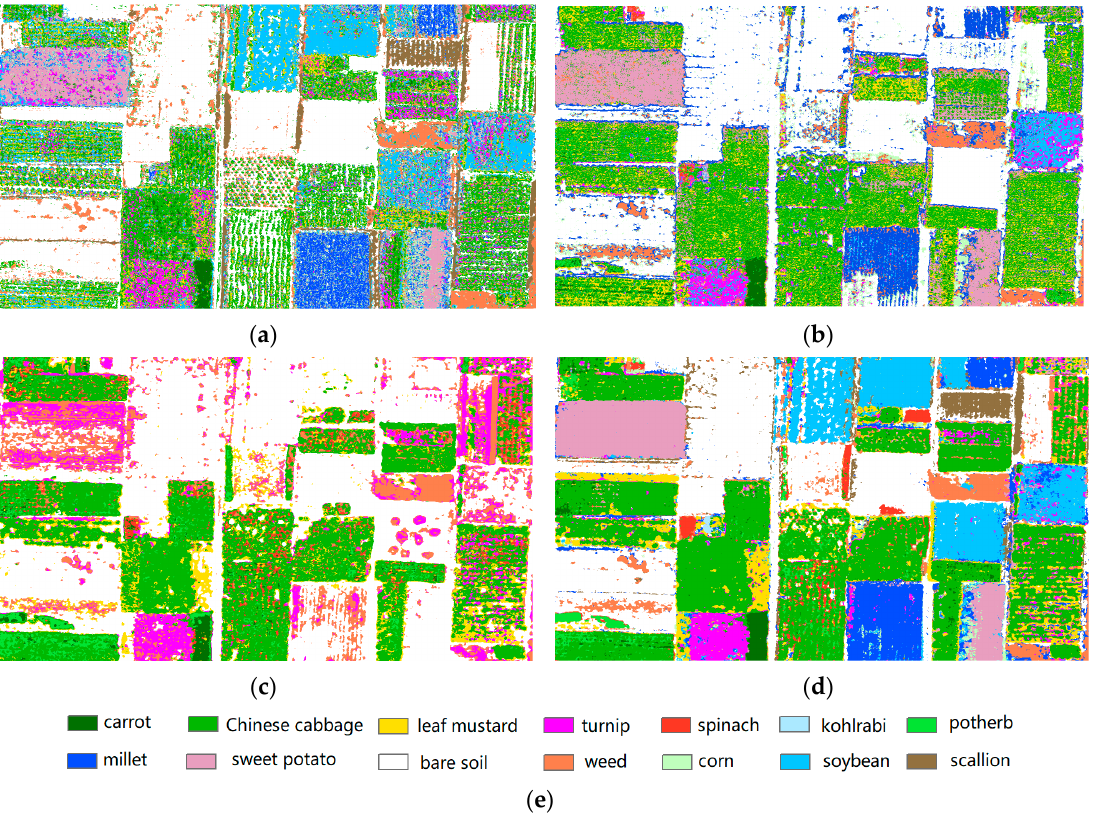
Figure 9. Vegetable map generated from ( a ) T1/2019-09; ( b ) T2/2019-10; ( c) T3/2019-11 and ( d ) Figure 9. Vegetablemapgeneratedfrom( a )T1 / 2019-09; ( b )T2 / 2019-10; ( c )T3 / 2019-11and( d )multi-temporal multi-temporal datasets using the proposed method. ( e ) Legend. datasets using the proposed method. ( e )